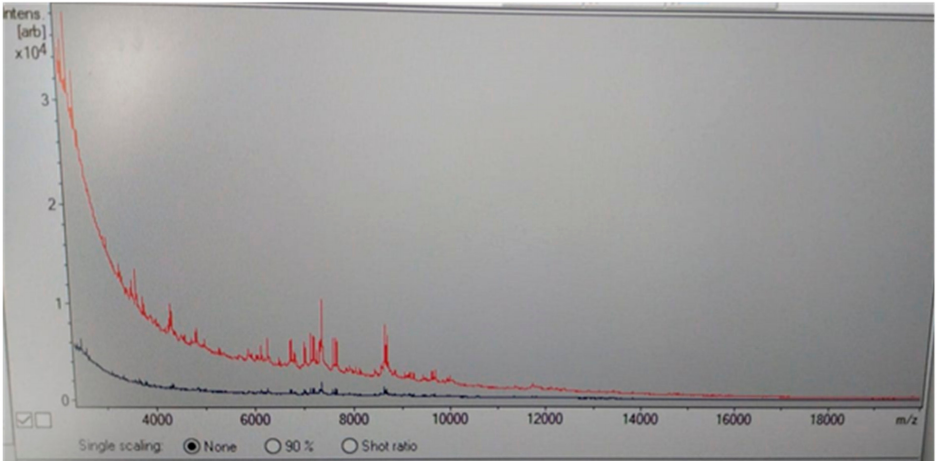
Figure 2. Maldi Toff spectrometry of Cryptococcus neoformans colony (red line) respect to control line (blue line).